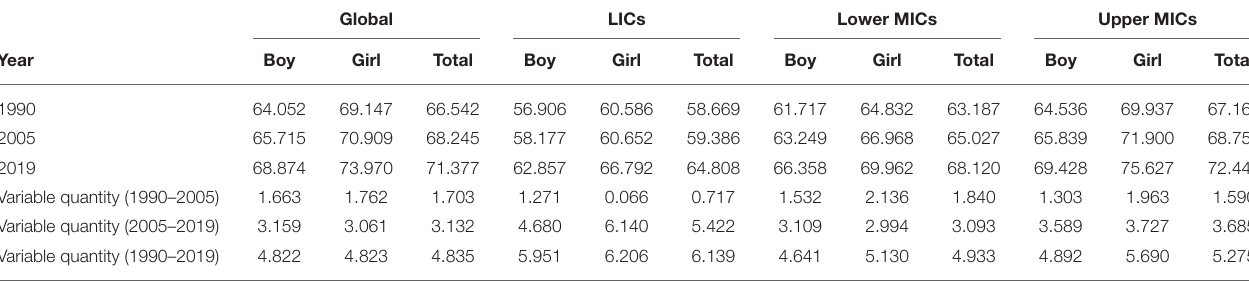
TABLE 2 | Life expectancy and changes in children aged 5–14 years from 1990 to 2019. Global LICs Lower MICs Upper